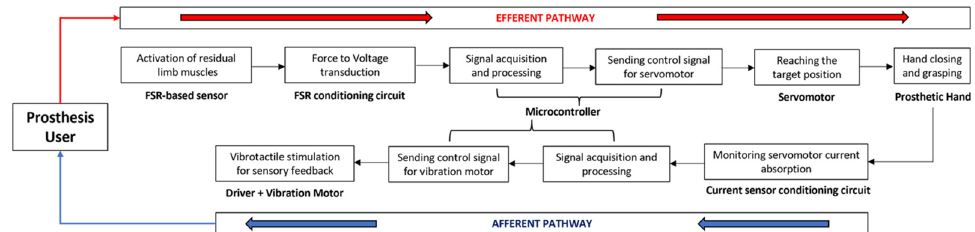
Figure 5. Flowchart describing the efferent pathway (force-myographic control system) and the afferent pathway (vibrotactile sensory feedback system).